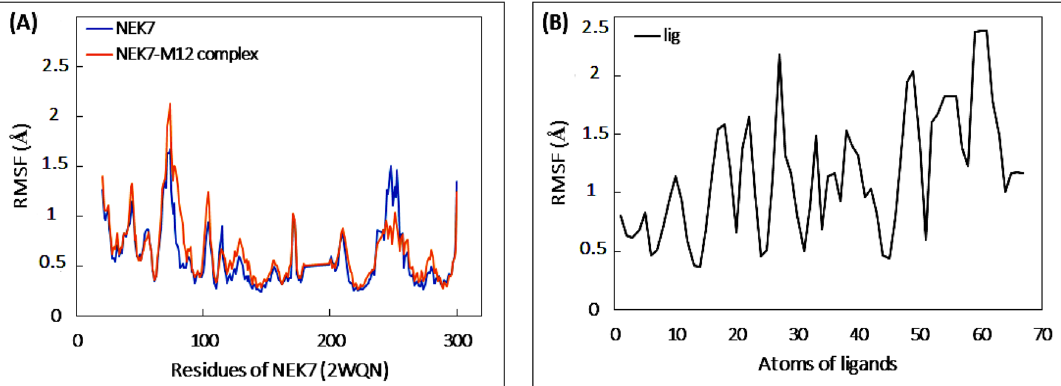
Figure 10. ( A ) Root mean square fluctuation (RMSF) of Cα atoms of NEK7 in the absence and presence of M12. ( B ) RMSF of each atom of M12.